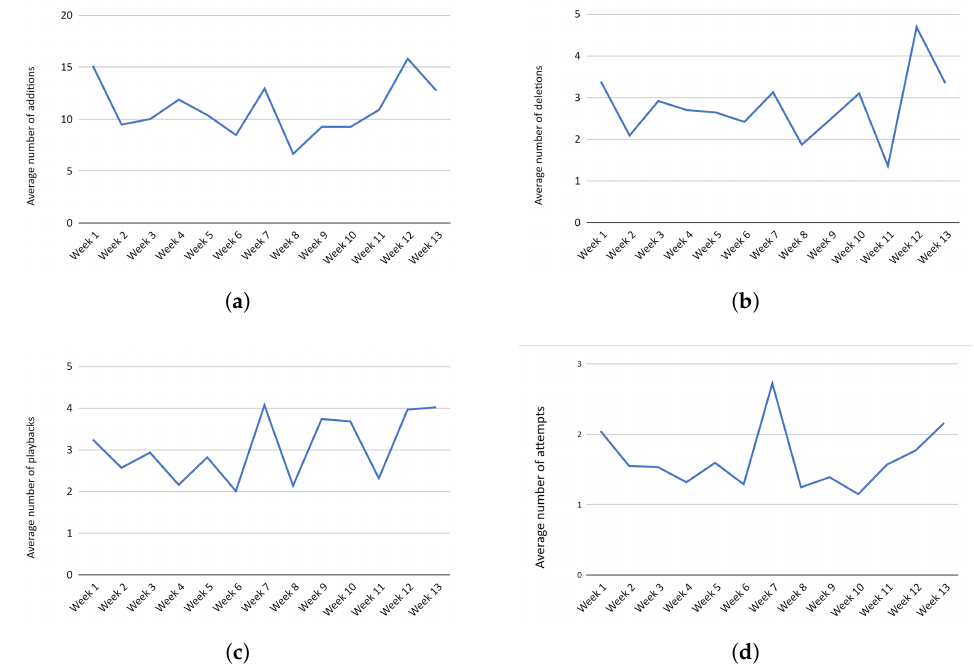
Figure 10. Visualizations of user actions within the exercise (addition, deletion, exercise playback and solving attempts. ( a ) Average number of additions per exercise; ( b ) Average number of deletions per exercise; ( c ) Average number of playbacks per exercise; ( d ) Average number of solving attempts per